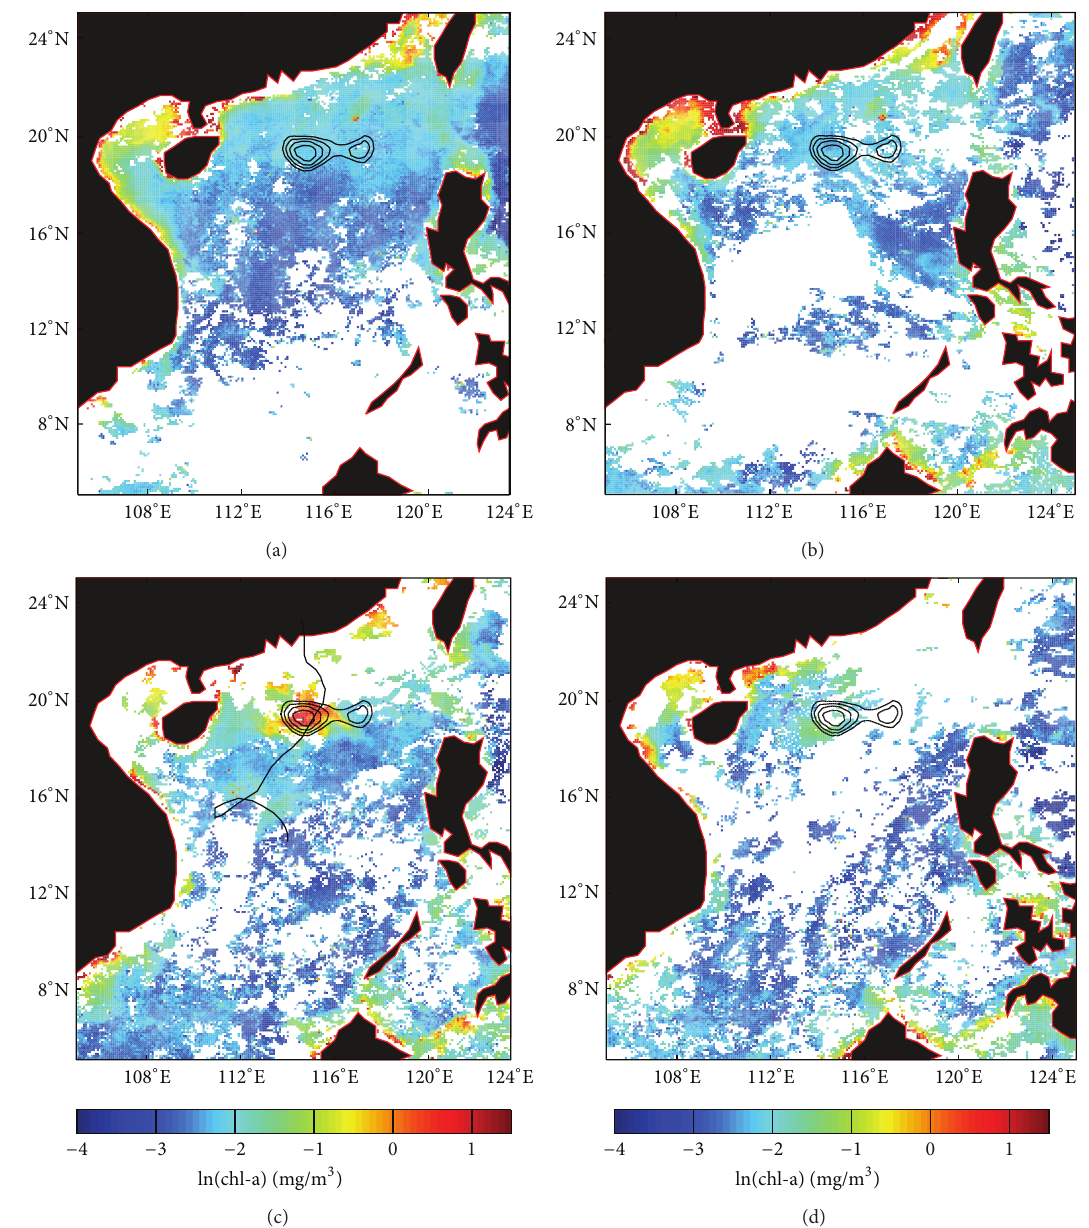
Figure 4: The chl-a concentration change under the influence of typhoon Leo in the CCE area. Colorbar is the natural logarithm value of chl-a concentration. (a), (b), (c), and (d) are the 8-day mean chlorophyll concentration derived from SeaWiFS in the SCS. (a) 15 April–22 April, 1999. (b) The prestorm chl-a distribution from 23 April to 30 April, 1999. (c) The poststorm chl-a distribution from 1 May to 8 May, 1999. The black solid line is the track of Leo. (d) 9 May–16 May, 1999. The contour indicates the CCE influenced by Leo. In (a), (b), (c), and (d), the CCE is the same one as on 30 April when CCE passed by